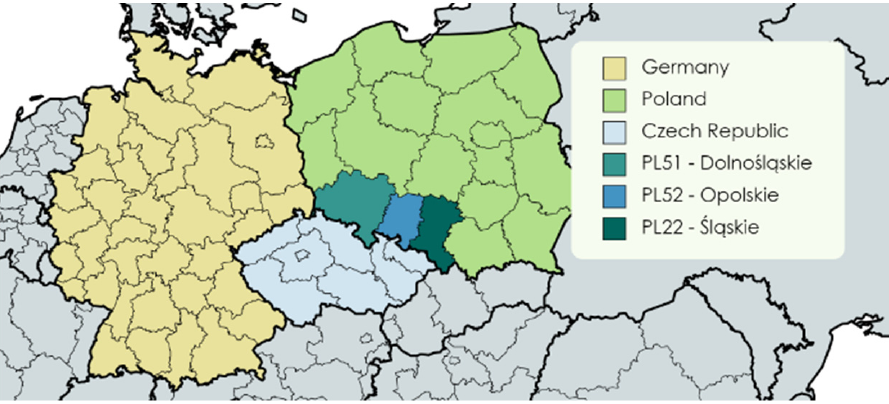
Figure 1. The surveyed regions of Poland (NUTS 2): Dolno ś l ą skie (PL51), Opolskie (PL52), and Ś l ą skie (PL22). Source: Own elaboration.